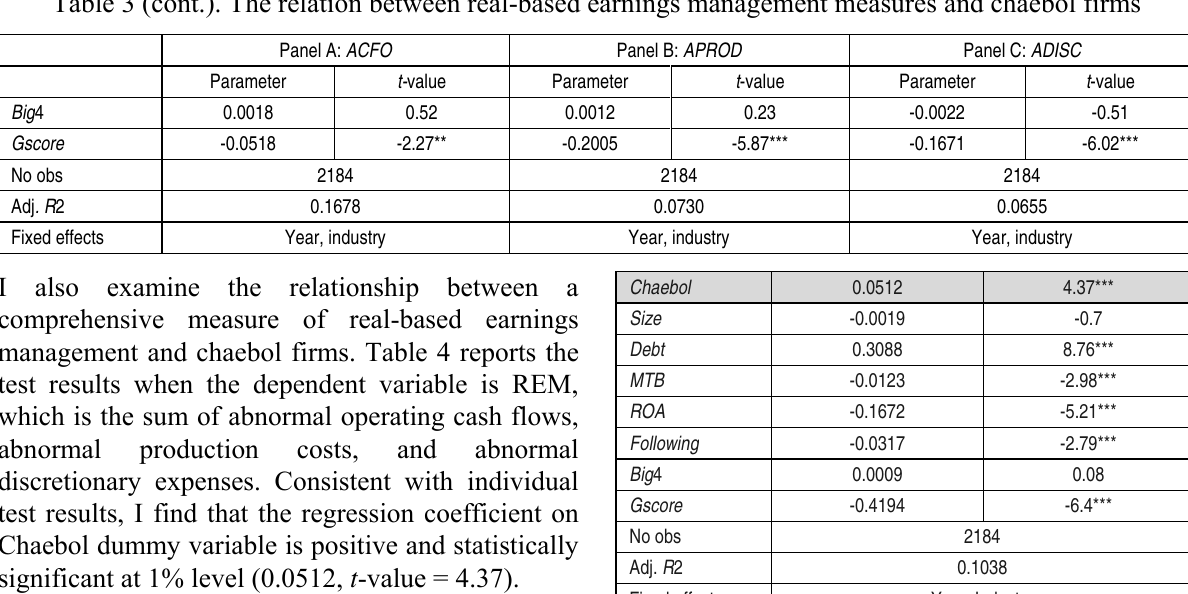
Table 3 (cont.). The relation between real-based earnings management measures and chaebol firms